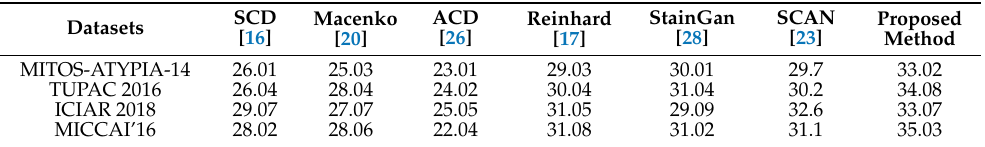
Table 1. Comparison of PSNR of different color normalization methods using various histopathol- ogy datasets.